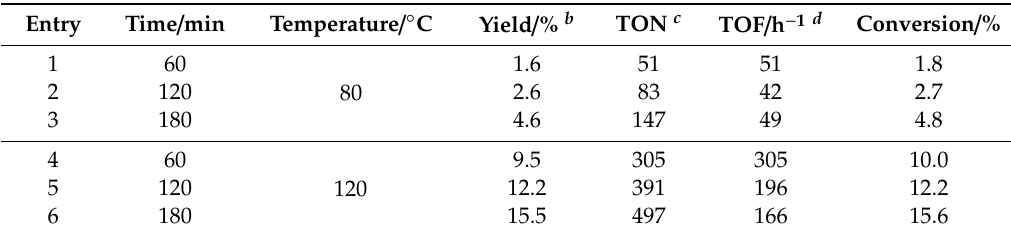
Figure 5. SEM images of: ( a ) Fe 3 O 4 /TiO 2 ; ( b ) Fe 3 O 4 /TiO 2 /[FeCl 2 { κ 3 - HC(pz) 3 }].